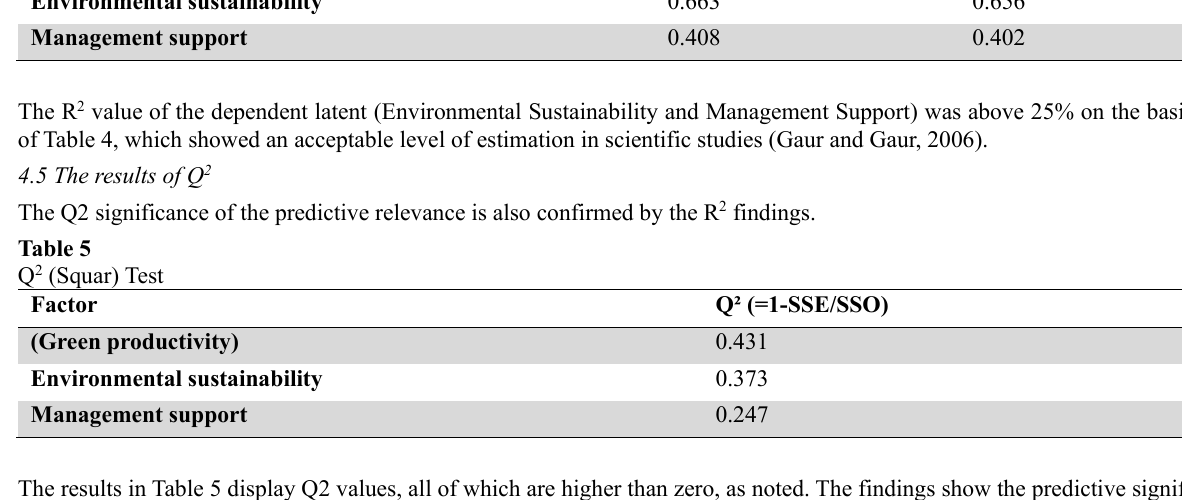
The summary of the results of R-Square values (Green